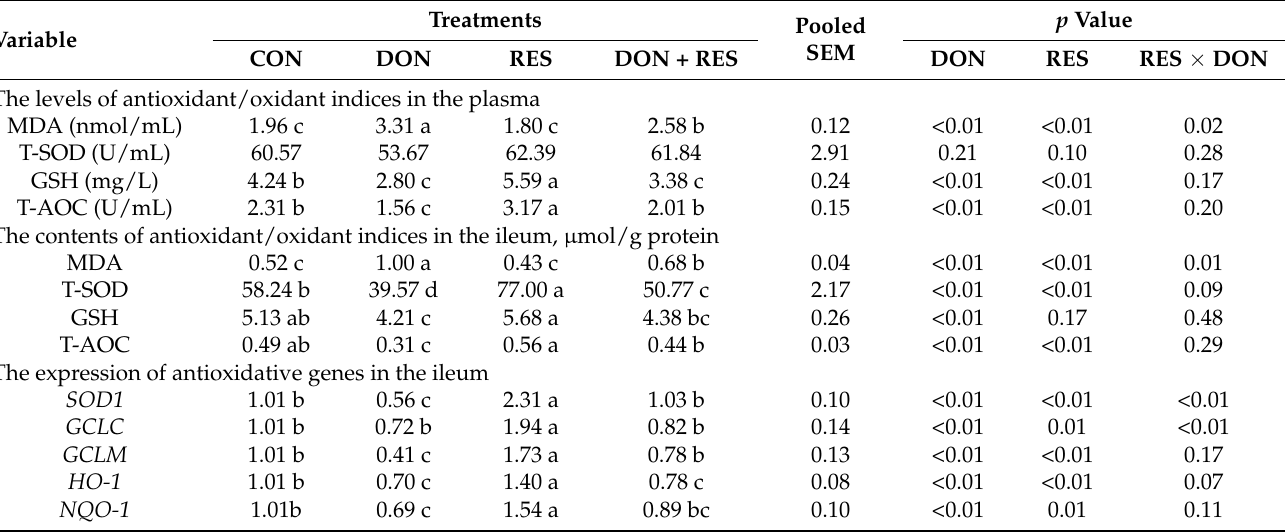
Table 4. Effect of resveratrol supplementation on the redox status in the plasma and ileum of DON-challenged piglets 1